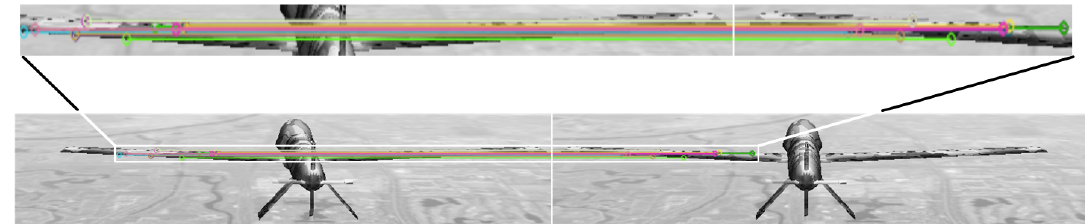
Figure 7. Feature points after